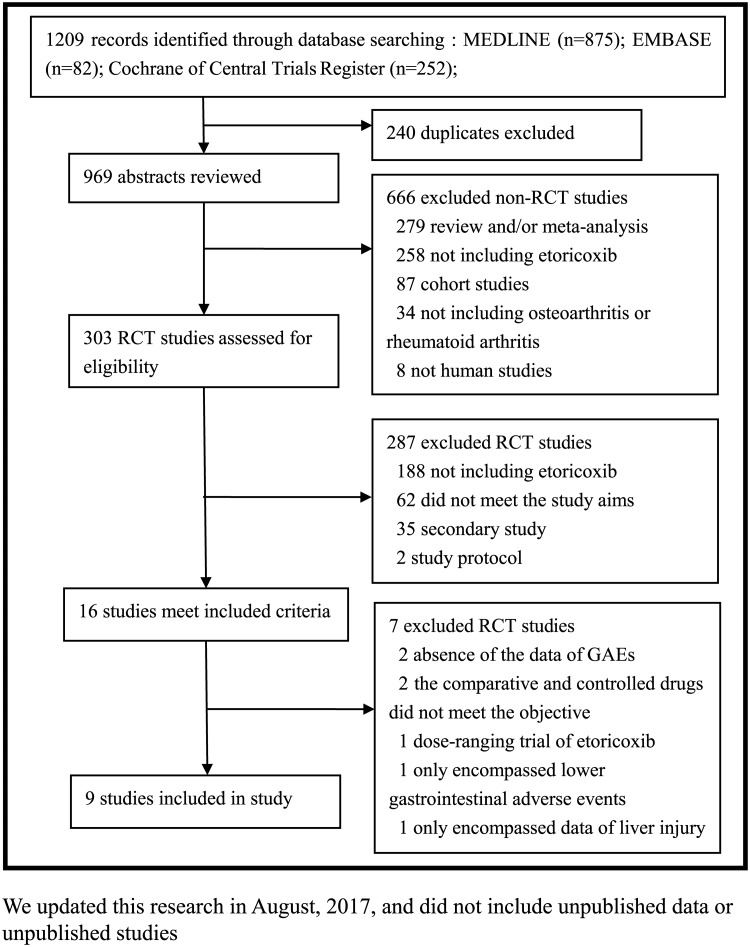
Flow-chart of study selection process.